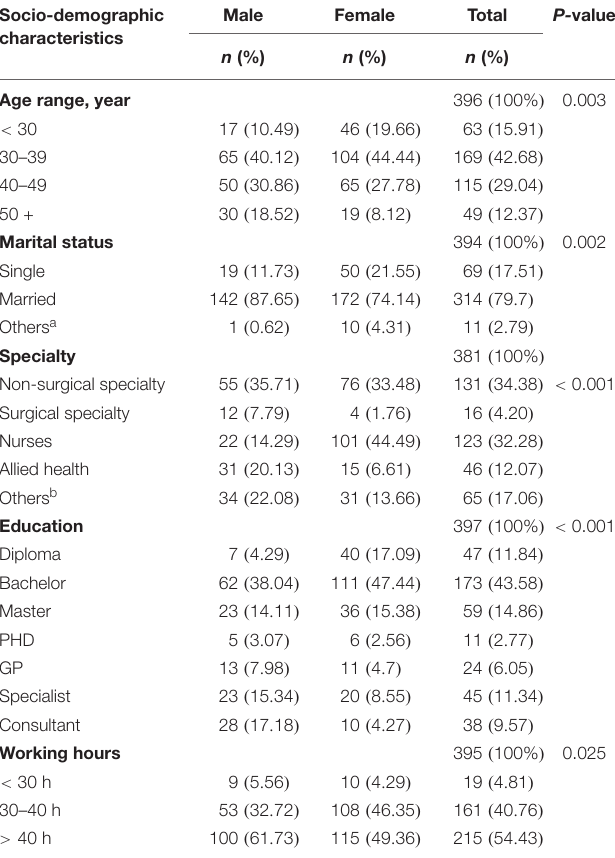
TABLE 1A | Participant socio-demographic